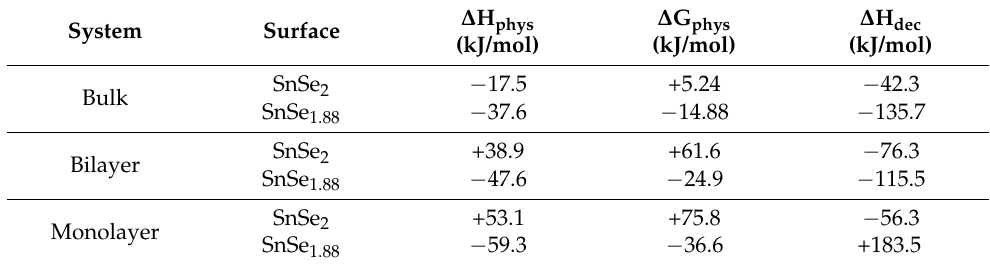
Table 2. Differential enthalpy ( ∆ H phys ) and Gibbs free energy ( ∆ G) at an operational temperature of 200 ◦ C for the physisorption of molecular oxygen at the surface of bulk, bilayer, and monolayer SnSe 2 and SnSe 1.88 . The differential enthalphy for oxygen decomposition ( ∆ H dec ) is also reported. All energies are expressed in